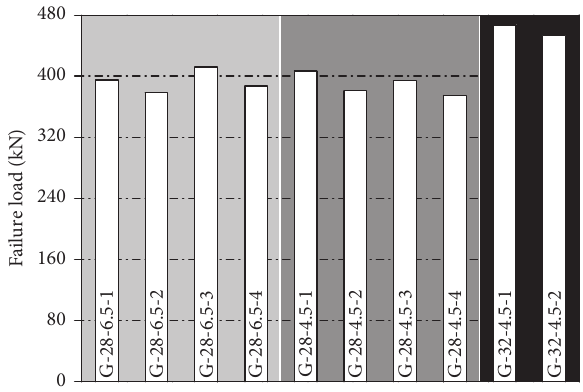
Figure 10: Summary of the anchor failure